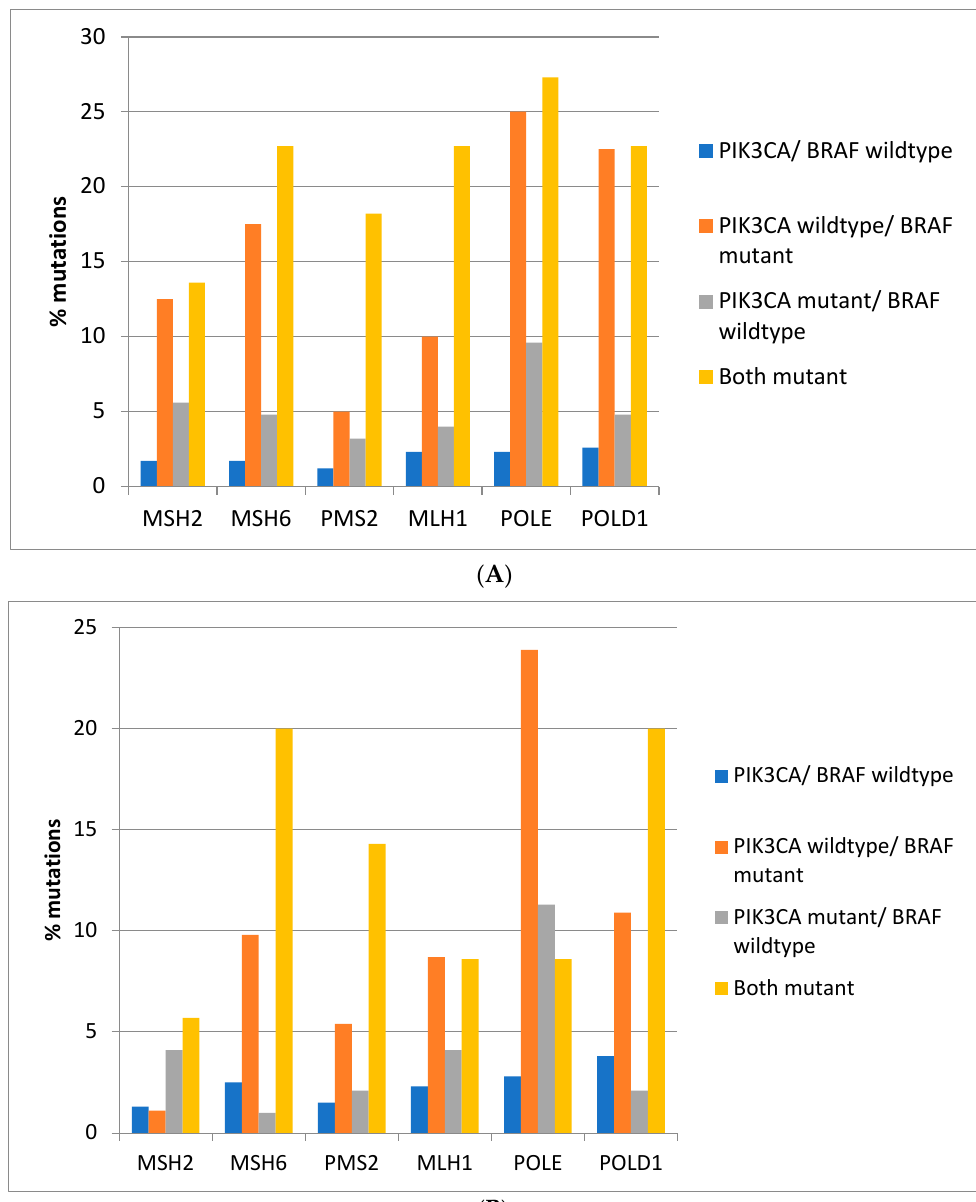
Figure 2. Prevalence of mutations in cancer-associated genes frequently mutated in colorectal cancer in colorectal cancer patients with or without BRAF and PIK3CA mutations. ( A ) TCGA cohort. ( B ) DFCI cohort.